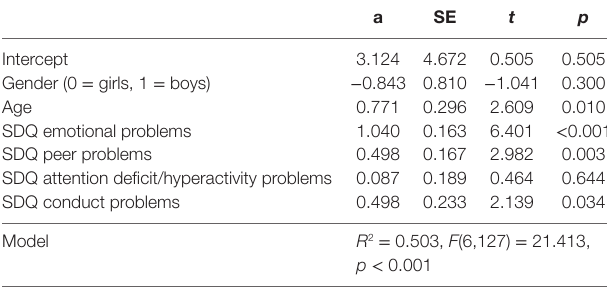
TaBle 3 | Results of the multiple regression analyses with ILK Self-report scale as dependent.